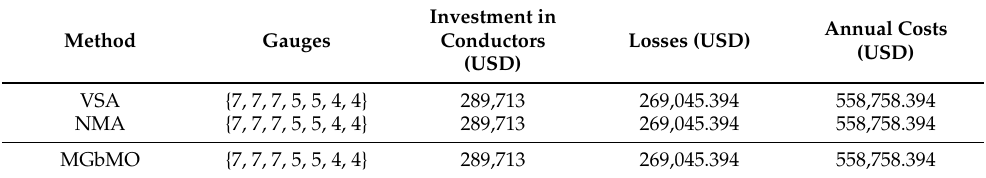
Table 10. Numerical results for the IEEE 8-bus system (unbalanced).